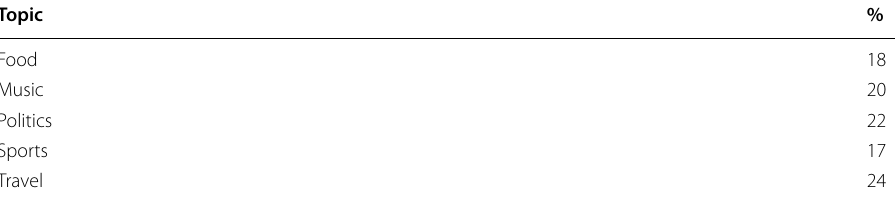
Table 1 Round percentages of the topics’ distribution Topic %